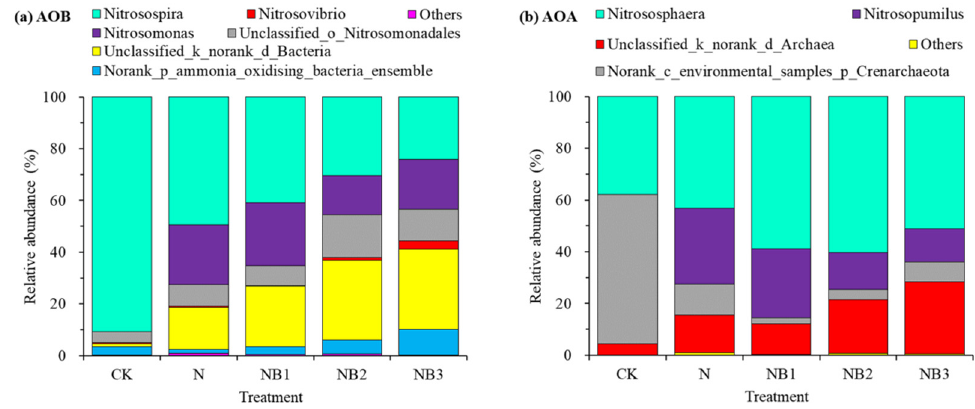
Figure 1. Relative abundance of AOB ( a ) and AOA ( b ) community structures at the genus level. The relative abundance of the AOA community at the genus level is shown in Figure